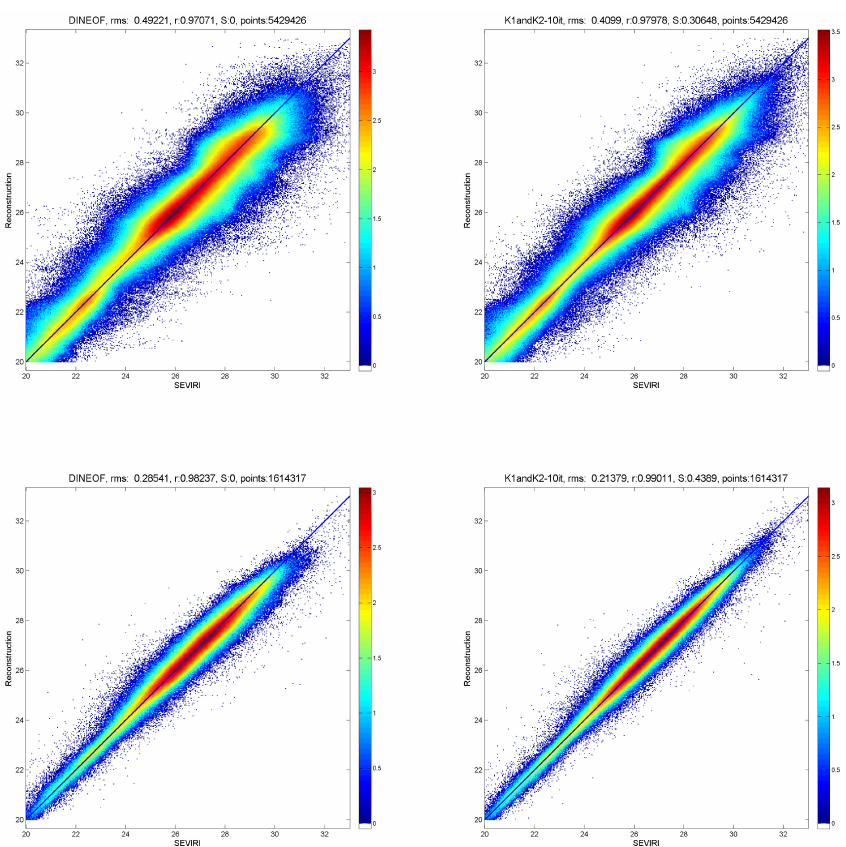
Figure 4. Correlation at cross-validation points using DINEOF alone and the new method DINEOFOI in Setup 3 and Setup 4.